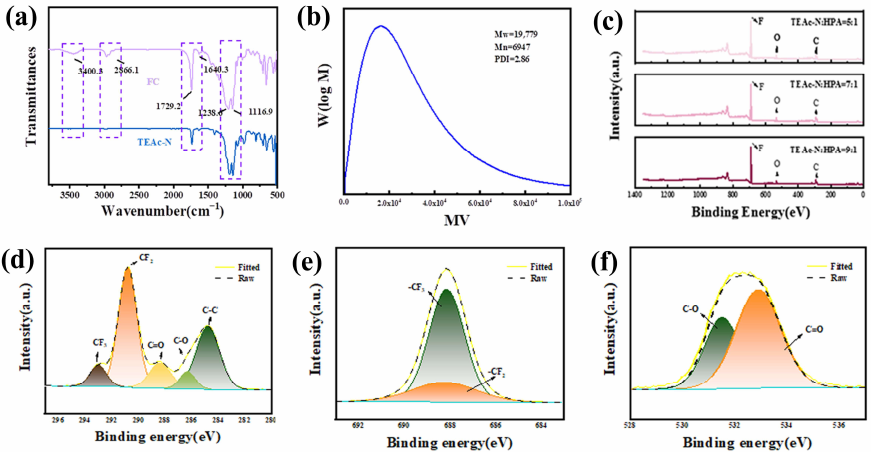
Figure 3. ( a ) FTIR of TEAc-N and FC; ( b ) GPC diagram of FC; ( c ) XPS full spectra of different ratios of FC; ( d ) XPS analysis: survey spectrum high-resolution spectra of C1s in FC (TEAc-N:HPA = 9:1); ( d ) FTIR spectra of different ratios of FC; ( e ) XPS analysis: survey spectrum high-resolution spectra of F1s in FC (TEAc-N:HPA = 9:1); ( f ) XPS analysis: survey spectrum high-resolution spectra of O1s in FC (TEAc-N:HPA =